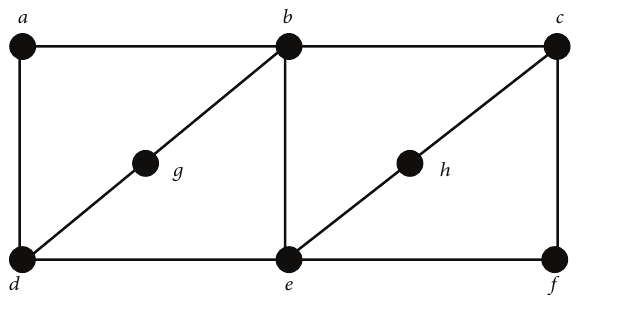
Figure 1: A simple graph.